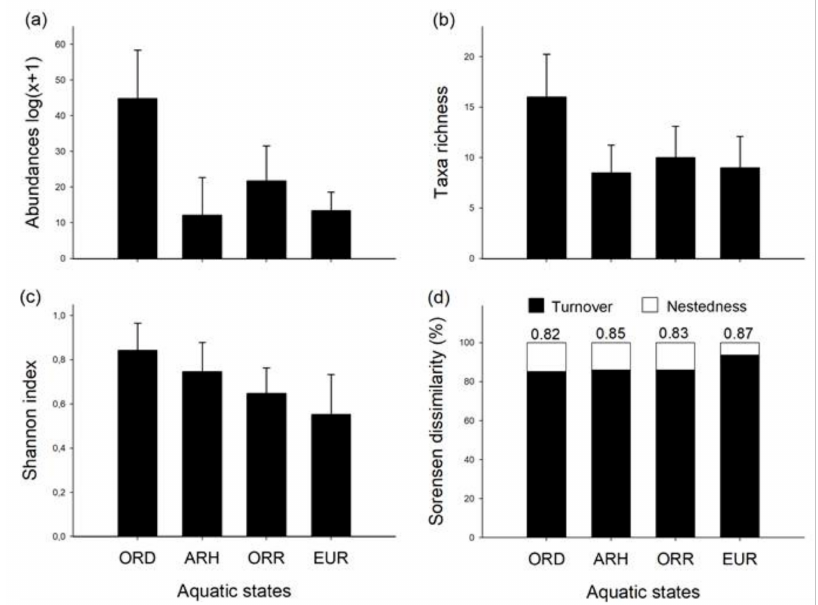
Figure 4. Mean of taxonomic metrics with standard deviation (—) for the distinguished aquatic states in the Lonqu é n River. Abundance log (x + 1) ( a ); taxa richness ( b ); Shannon index ( c ); Sorensen dissimilarity (Turn-over %) ( d ) (see acronyms of aquatic states in Figure